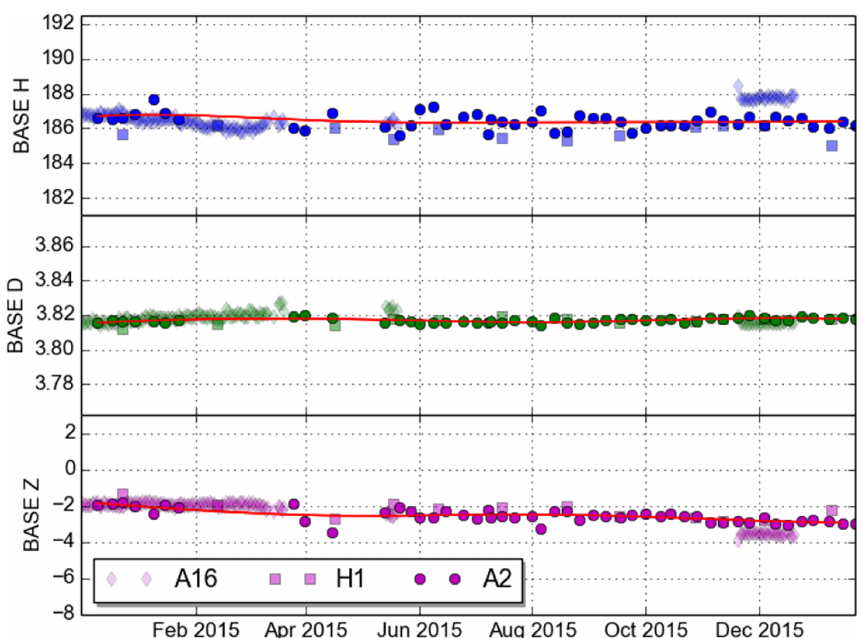
Figure 7. Baseline value for FGE variometer, A16 AutoDIF, H1, and A2 manual measurements ( H and Z in nT and D in degrees) (Leonhardt et al., 2015).